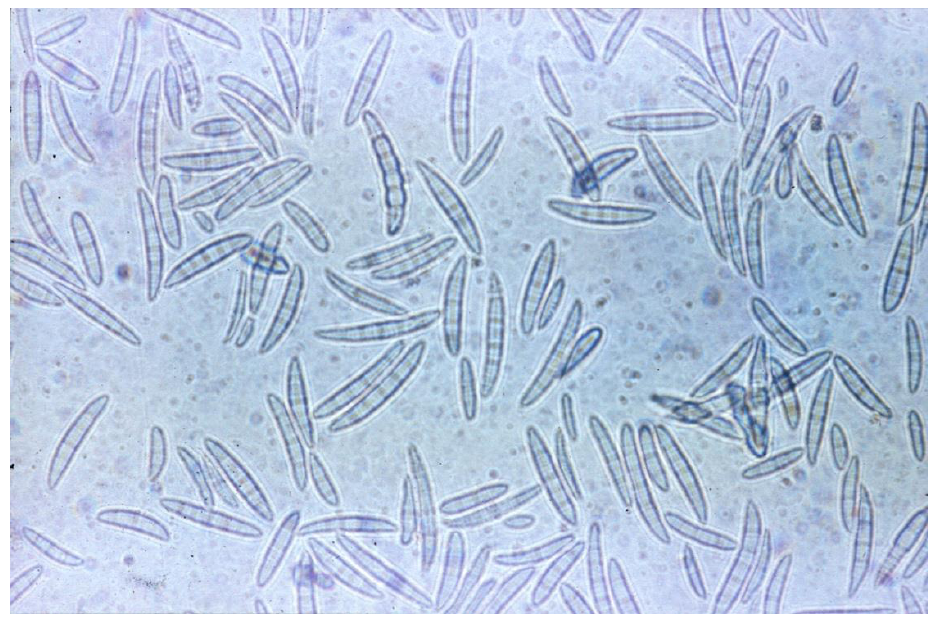
Figure 1. Macroconidia of Fusarium